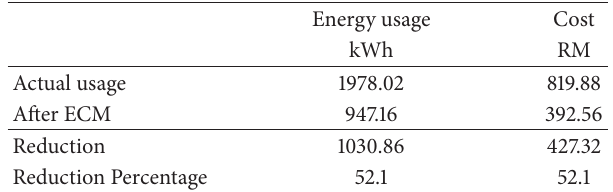
Table 12: Potential energy reduction and cost savings from the